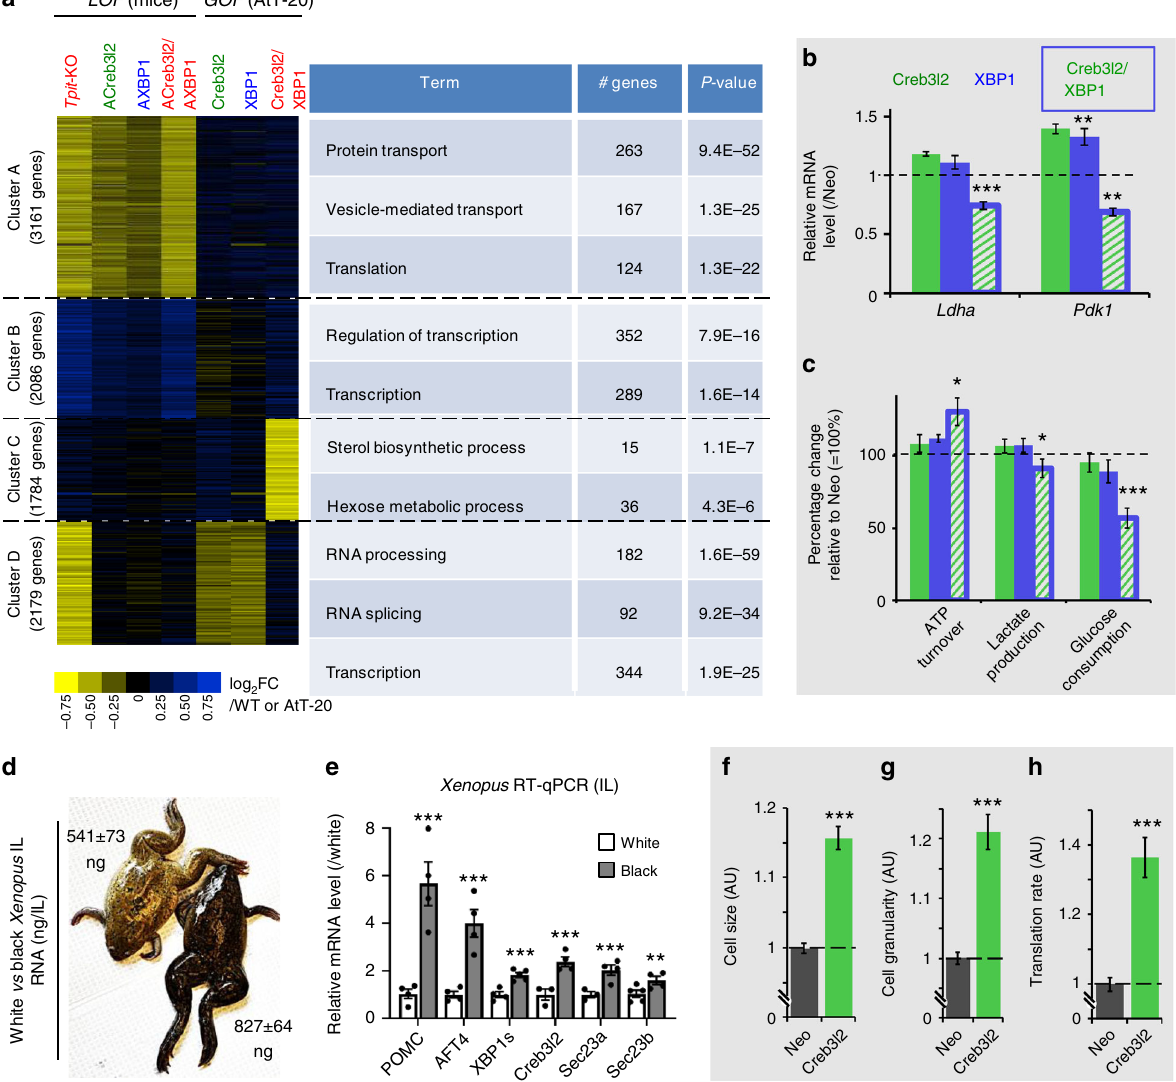
Fig. 5 Creb3l2 is a scaling factor for translation. a Tpit KO transcriptome signature is largely phenocopied by inhibition of Creb3l2 and XBP1 . Heatmap representation of gene clustering identi fi ed by global analysis of expression pro fi ling datasets ( left ) and GO distribution of genes in each cluster ( right ). Transcriptome data from WT, Tpit-KO , ACreb3l2 , AXBP1 , and ACreb3l2/AXBP1 transgenic mice and from the gain-of-function AtT-20 cells were clustered with the Cluster 3.0 software using K -means. P -values relative to random occurrence using modi fi ed Fisher Exact P -value (EASE scores provided by DAVID) are shown. b Decreased lactate dehydrogenase (Ldha) and pyruvate dehydrogenase kinase (Pdk1) mRNAs (RNAseq normalized counts) in AtT- 20 cells expressing Creb3l2 + XBP1 relative to control (Neo) cells set to 1. c Increased ATP turnover, decreased lactate production and glucose utilization, showing shift of ATP production from glycolysis to oxidative phosphorylation in AtT-20 cells expressing Creb3l2 + XBP1. Data represent the means ± SEM ( n = 5 – 6). d Adaptation (5 weeks) of Xenopus skin color to black ( right ) background compared to white ( left ) increases total IL RNA content (ng ± SEM, for n = 4 – 5). e Expression of POMC and UPR genes in white (white bars) and black (black bars) background adapted frogs. Relative IL mRNA levels measured by RT-qPCR were normalized to those of β -actin and represented as fraction of levels in white background set to 1. Data represent means ± SEM (each dot represents independent measure). f – h Expression of Creb3l2 in INS-1 cells. FACS analyses of cell size f and granularity g index for INS-1 cells expressing Creb3l2. All data represent the means ± SEM ( n = 3). h SUnSET measurement of protein synthesis in control INS-1 cells (Neo) and INS-1 cells expressing Creb3l2. Data (±SEM, n = 3) are presented relative to Neo cell set to 1. Compared to controls using bilateral Student ’ s T -test with unequal variances: * P < 0.05, ** P < 0.005, *** P < implicated in translational control, such as the Akt/mTOR performed RNAseq on our LOF and GOF models and analyzed pathway. the results by unsupervised clustering analysis (RT-qPCR validation of representative genes is provided in Supplementary Fig. 1f). Four gene clusters (A – D) were identi fi ed and analyzed by gene ontology (GO) (Fig. 5a). Two clusters appeared to be par- Creb3l2 a translation scaling factor . To evaluate to which extent ticularly interesting: clusters A and C. Cluster A is enriched in gene expression changes dependent on Creb3l2 or/and XBP1 genes controlling protein transport and translation that tend to be resemble gene expression changes caused by Tpit inactivation, we